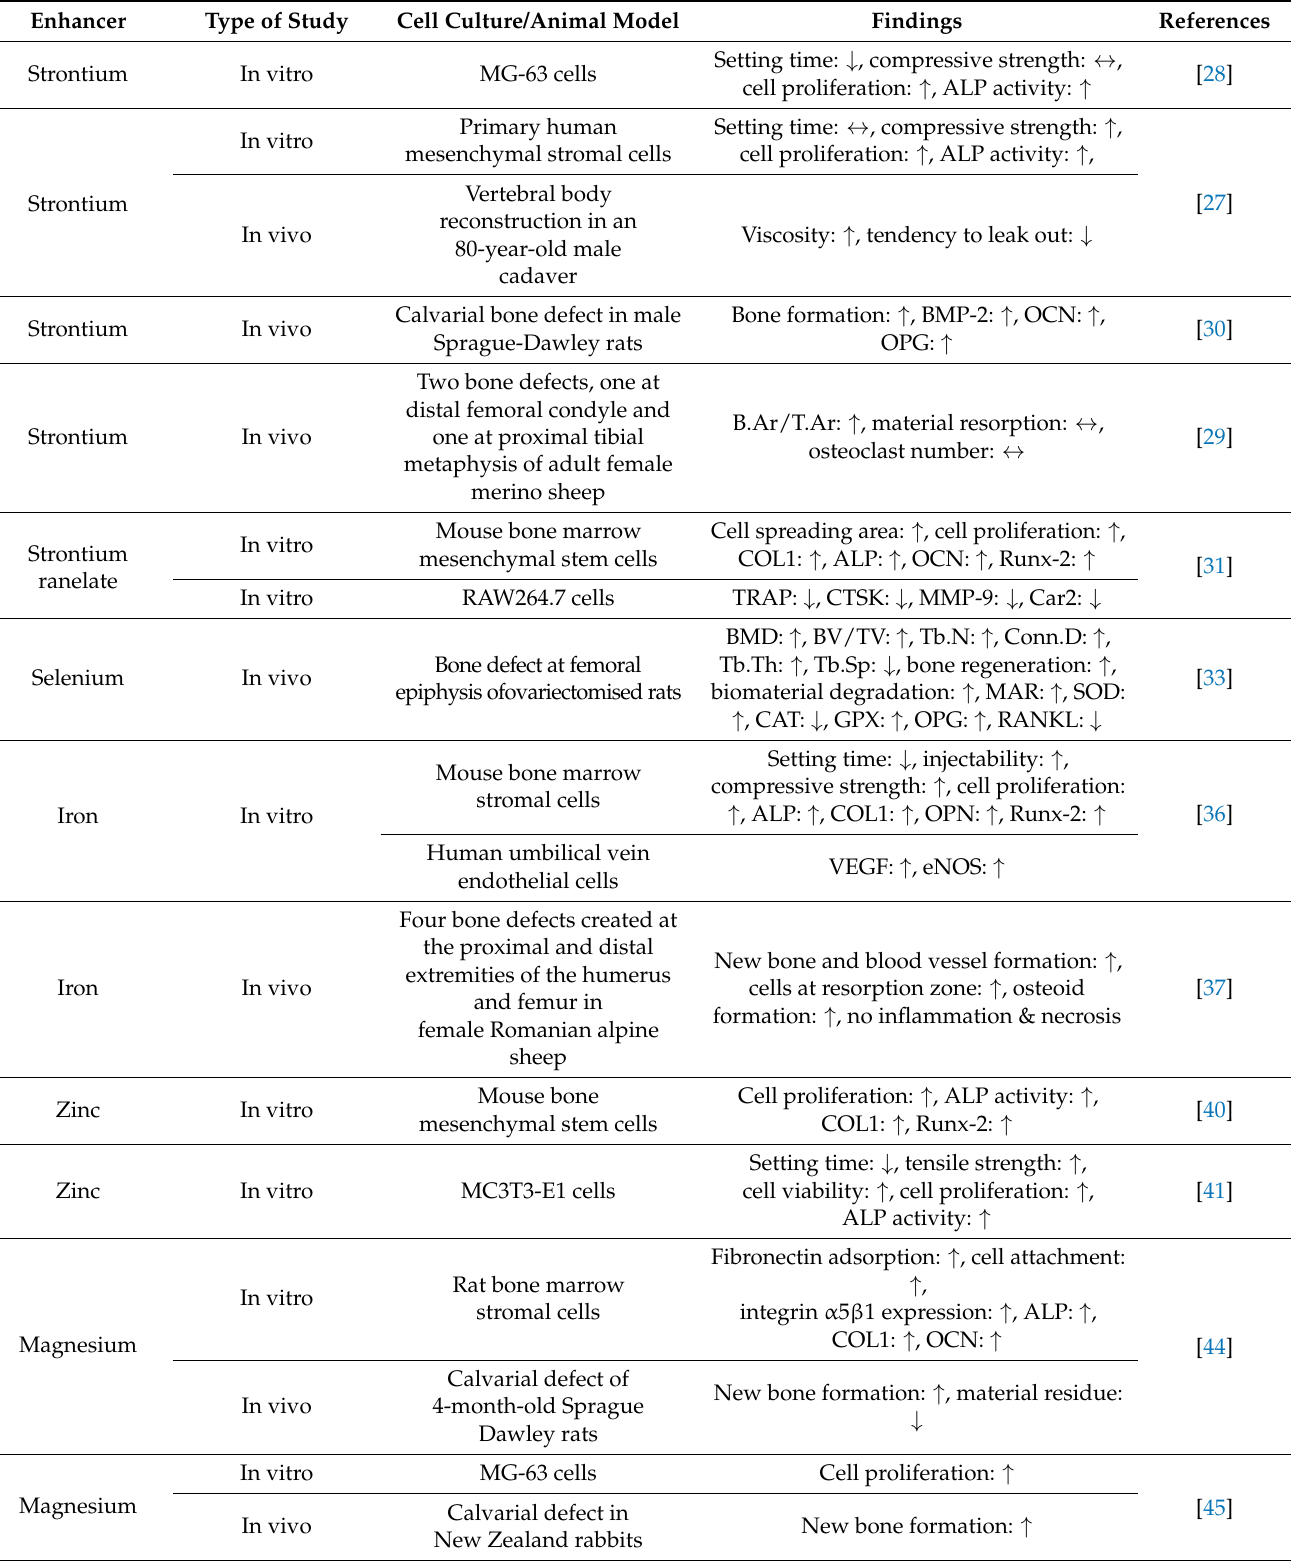
Table 3. Bone-sparing properties of CPC enhanced by chemical